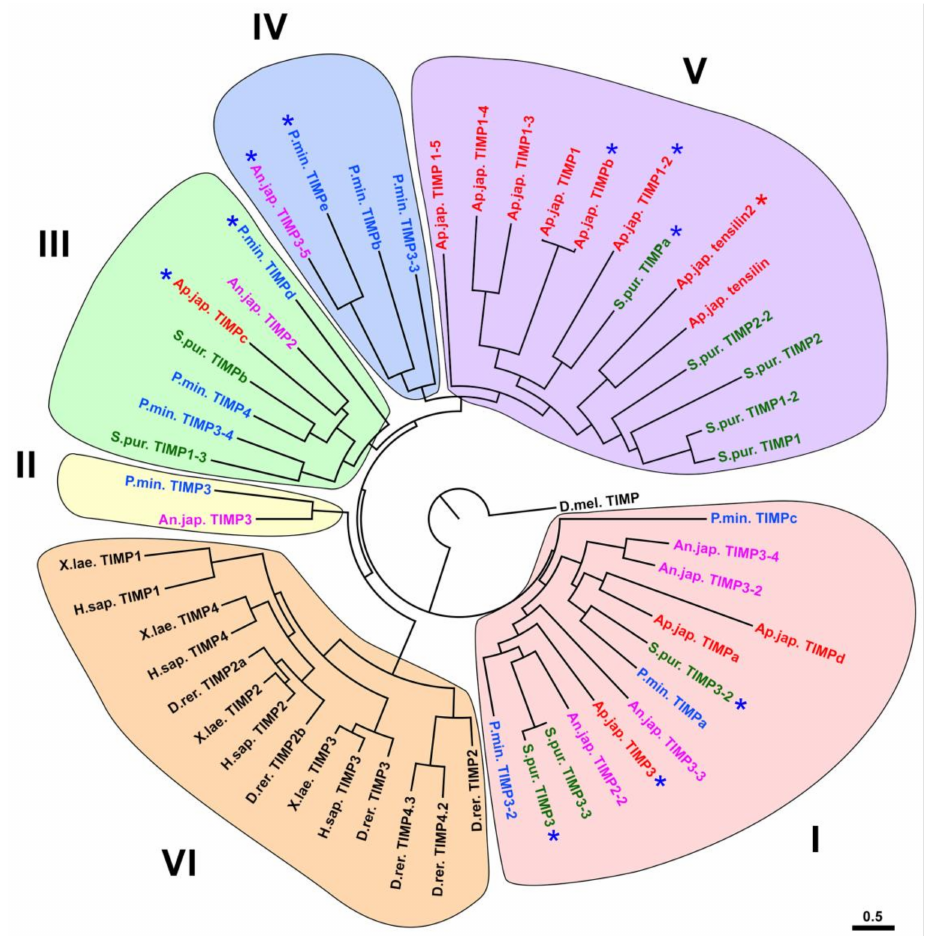
Figure 8. Phylogenetic tree showing the relationships of TIMPs of echinoderms. Crinoids ( Anneissia japonica )—pink color, asteroids ( Patiria miniata )—blue color, echinoids ( Strongylocentrotus purpuratus )— green color, holothurians ( Apostichopus japonicus )—red color, red asterisk—tensilin, blue asterisks— TIMP-like proteins that lack cysteines at the N-terminus of the molecule and/or the HPQ binding site. Construction of the phylogenetic tree was done using the MrBayes/Maximum Likelihood algorithm and the online service CIPRES (http://www.phylo.org, accessed on 15 March 2021). The nucleotide and amino acid sequences were analyzed using the Partitionfinder 2.1.1 [101,102]. The trees were visualized in the FigTree